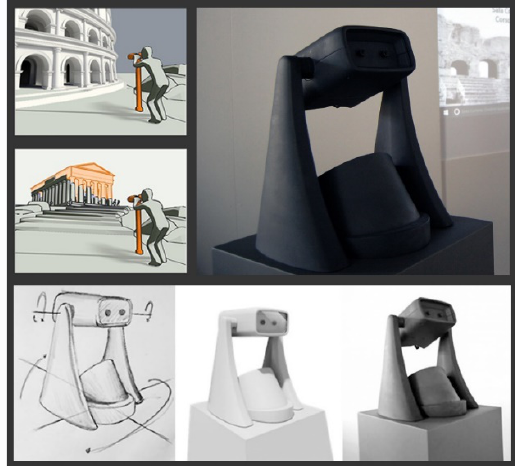
Figur e 11: DIVAR. Below sketch, 3D Model and Device Made (photo and SpinVector